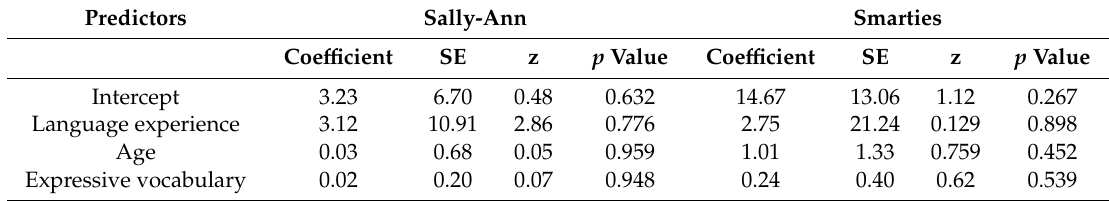
Table 9. Summary of logit mixed e ff ects models: Verbal Theory of Mind tasks. Predictors